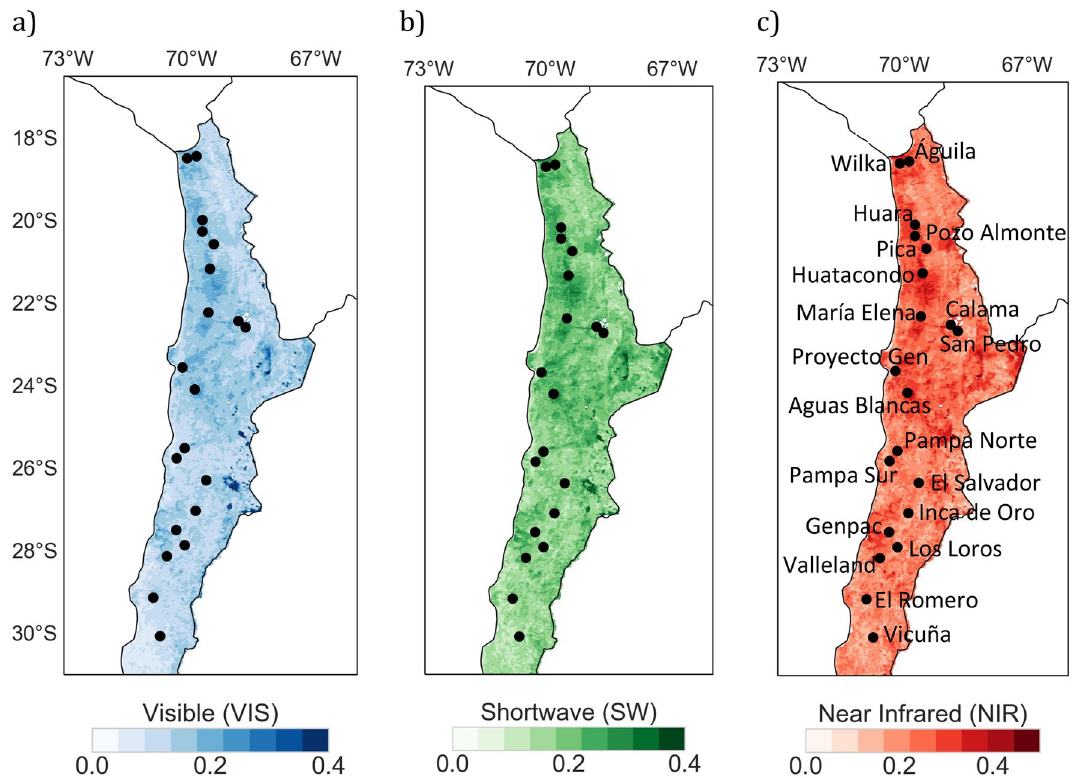
Figure 1. Satellite-derived estimates of the white-sky albedo averaged over the period 2011–2020 for the following broadbands: ( a ) Visible (VIS), ( b ) Shortwave (SW), and ( c ) Near infrared (NIR). Measurement sites are also indicated in the plots. Plots were generated using Python’s Matplotlib library 44 with data from